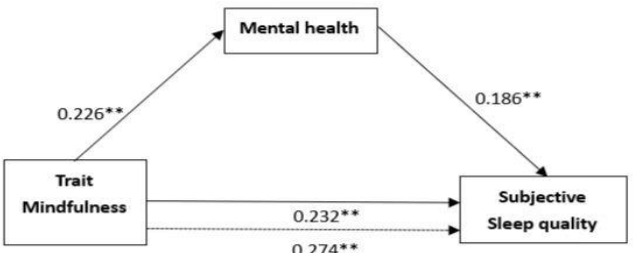
Figure 3. The mediation model of subjective sleep quality (Note: the dotted line denotes that the effect of trait mindfulness on self-rated health is not included as a mediator). ** p < 0.01.